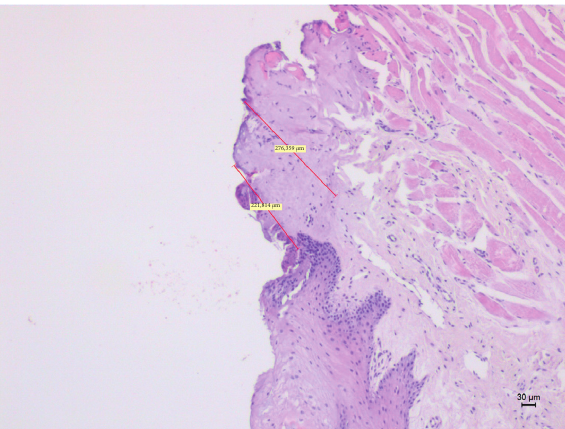
Figure 2: The histological specimen obtained using 4W in CW with colour EE at 10x magnification (group A).